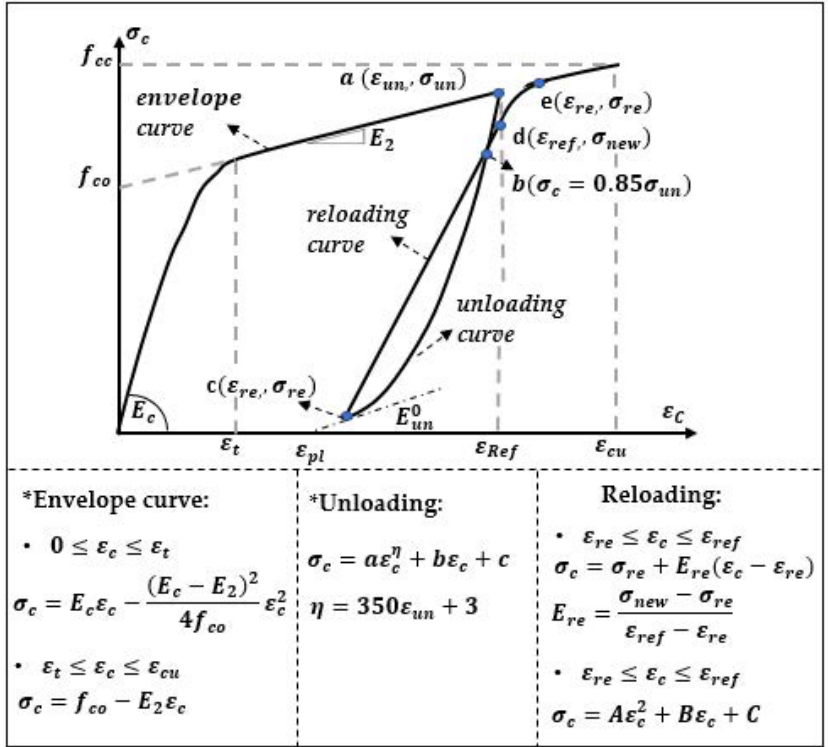
Figure 7. Concrete model according Lam et al. [33]. Sadeghi et al. [34] presented a constitutive law for a numerical simulation of the behavior of a reinforced concrete with the use of a uniaxial relation σ − ε for the description of a loading–unloading cycle. The increase in plastic strains during the loading and unloading with a consideration of transversal reinforcement was described in this model with the use of a parabolic